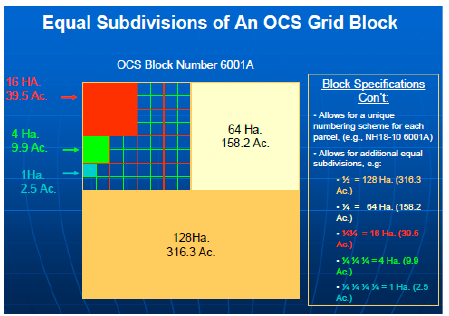
Figure 9. Grid System for oil and gas exploitation in USA [45].